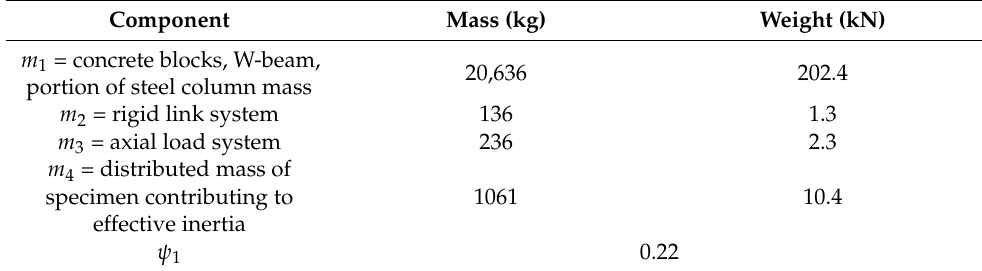
Table 1. Masses and dynamic weights of the